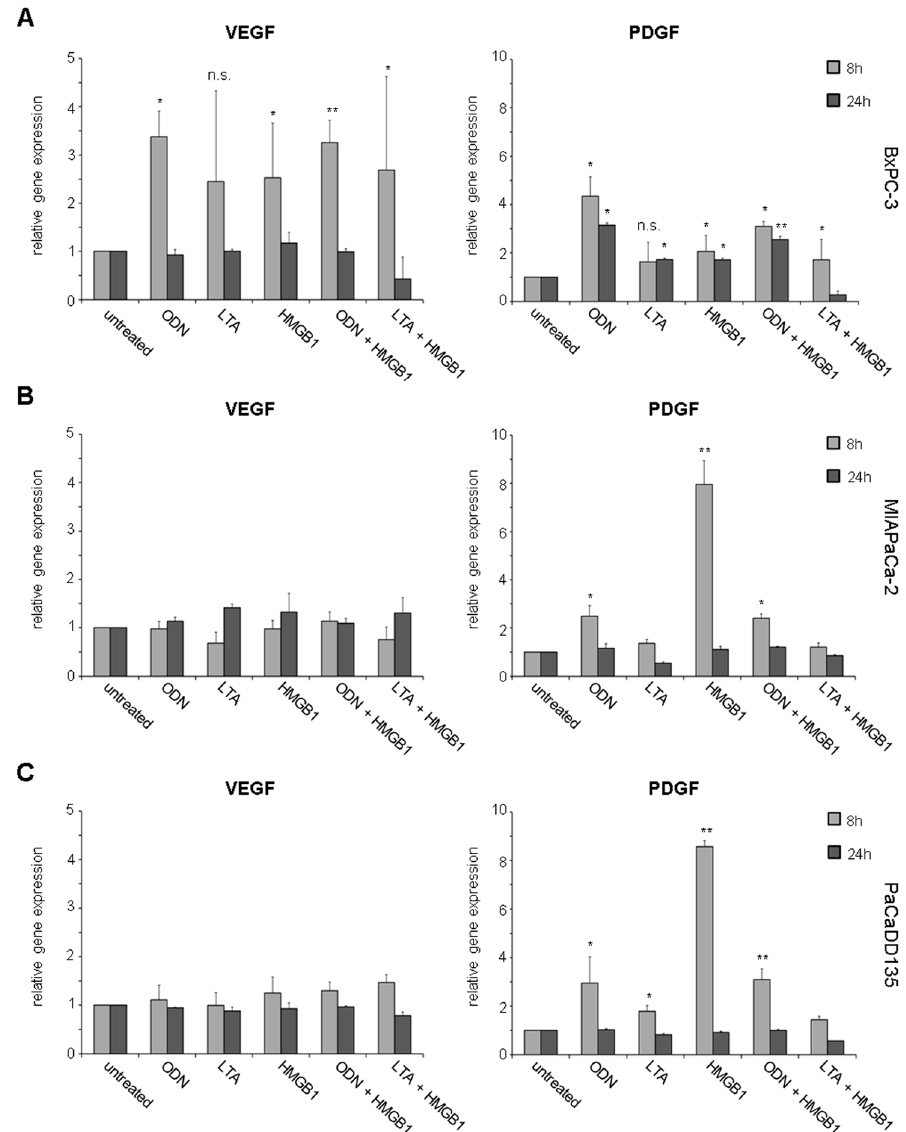
Figure 6. Gene expression analysis of VEGF and PDGF in pancreatic cancer cell lines after treatment with TLR ligands: BxPC-3 ( A ); MIAPaCa-2 ( B ); and PaCaDD135 ( C ) were incubated with ODN, LTA, HMGB1, ODN + HMGB1, and LTA + HMGB1 and analyzed by RT-qPCR 8 and 24 h after stimulation. Increased VEGF gene expression was observed only in BxPC-3 cells, whereas PDGF was significantly expressed in all three cancer cell lines. Untreated cells were standardized to baseline. The relative gene expression is expressed as 2 −ΔΔ C q . * p < 0.05, ** p < 0.005, n.s. not significant.